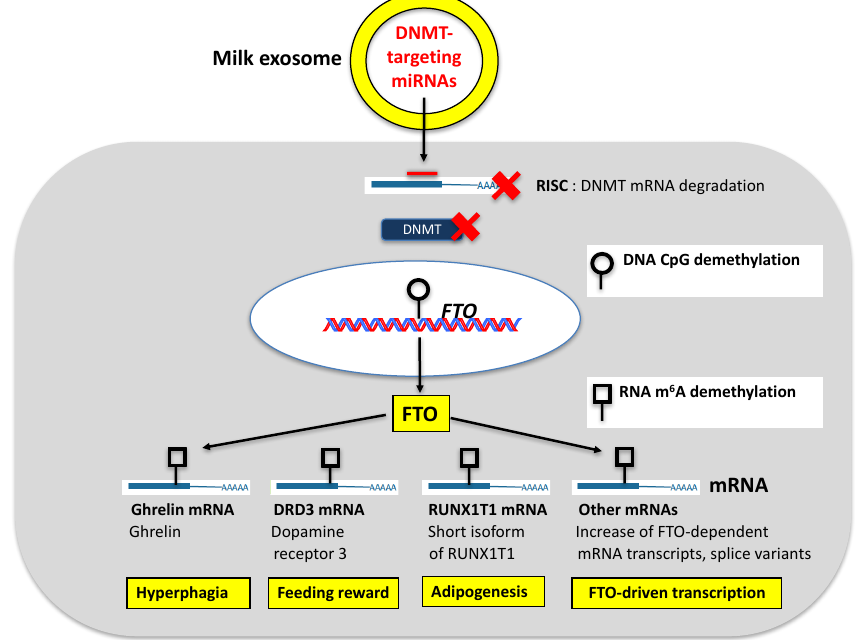
Figure 3. Working model of milk-mediated epigenetic actication of fat mass- and obesity-associated protein (FTO) expression modifying the epitranscriptome. Milk-derived DNMT-targeting miRNAs reduce methylation critical DNA CpG islets thereby increasing FTO gene expression. The RNA m 6 A demethylase FTO erases m 6 A marks on mRNAs, thereby enhancing FTO-dependent mRNA transcription and mRNA splice variant production such as adipogenic short form of RNX1T1. The mRNAs of ghrelin and dopamine receptor 3 (DRD3) are targets of FTO-mediated upregulation. Resulting hyperphagia and feeding rewards support milk intake for infant growth requirements. Via epigenetic upregulation of FTO expression milk regulates the m 6 A-controlled